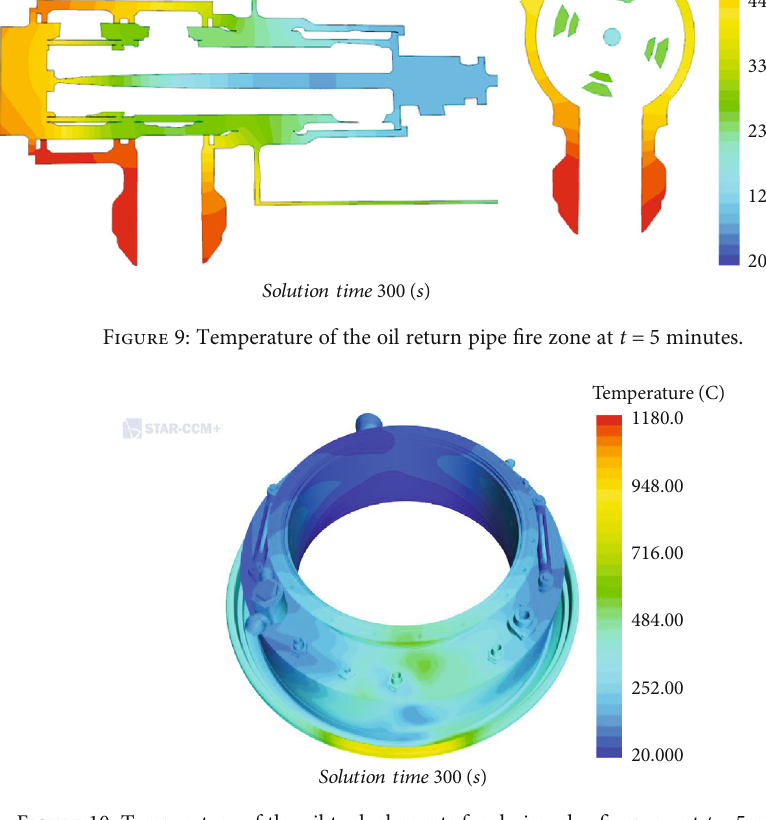
Figure 10: Temperature of the oil tank elements for drain valve fi re zone at t = 5